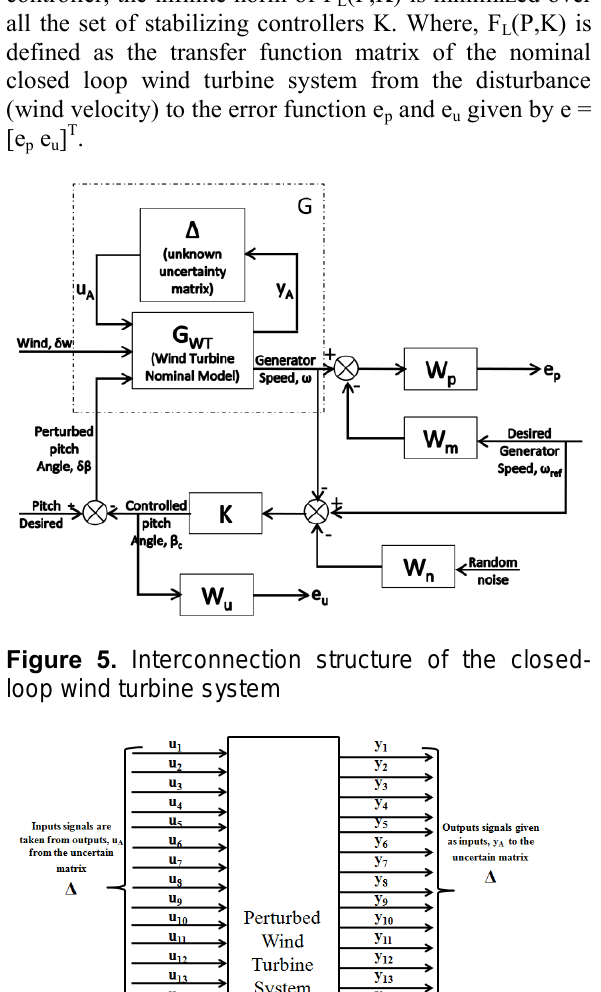
Figure 6. Generalised block diagram of open loop uncertain system The Matlab command “hinfsyn” computes a sub- optimal H ∞ controller based on the “ perturbed_sys” – an open loop structure . The controller has one input and one output with the value of gamma to be ≤ 1. From this proposed design the value of γ obtained is 0.4094 as shown in table.1 that represents the gamma calculations for the design of H ∞ controller. A 14 th order controller is obtained along with the H ∞ norm (γ = 0.4094) of the closed-loop system. The number of poles obtained in the design is 14 and the values of poles of the H ∞ controller obtained from simulations lie in the stable region given by: -300.01; -13.545 ± 36.705i; -24.232 ±